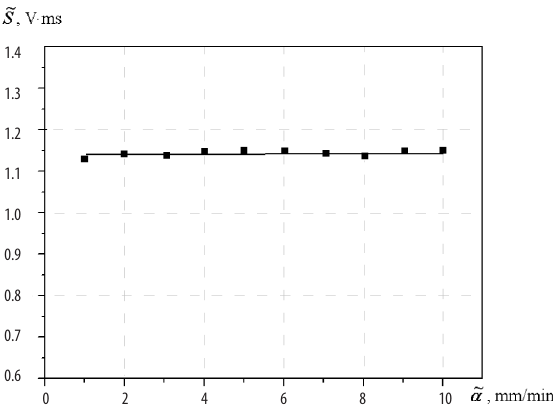
Fig. 6. Dependence of change of the area under the curve of experimental signals of AE from the speed of loading of specimens from VK4, got on the base method, that is described in work (Филоненко и др.